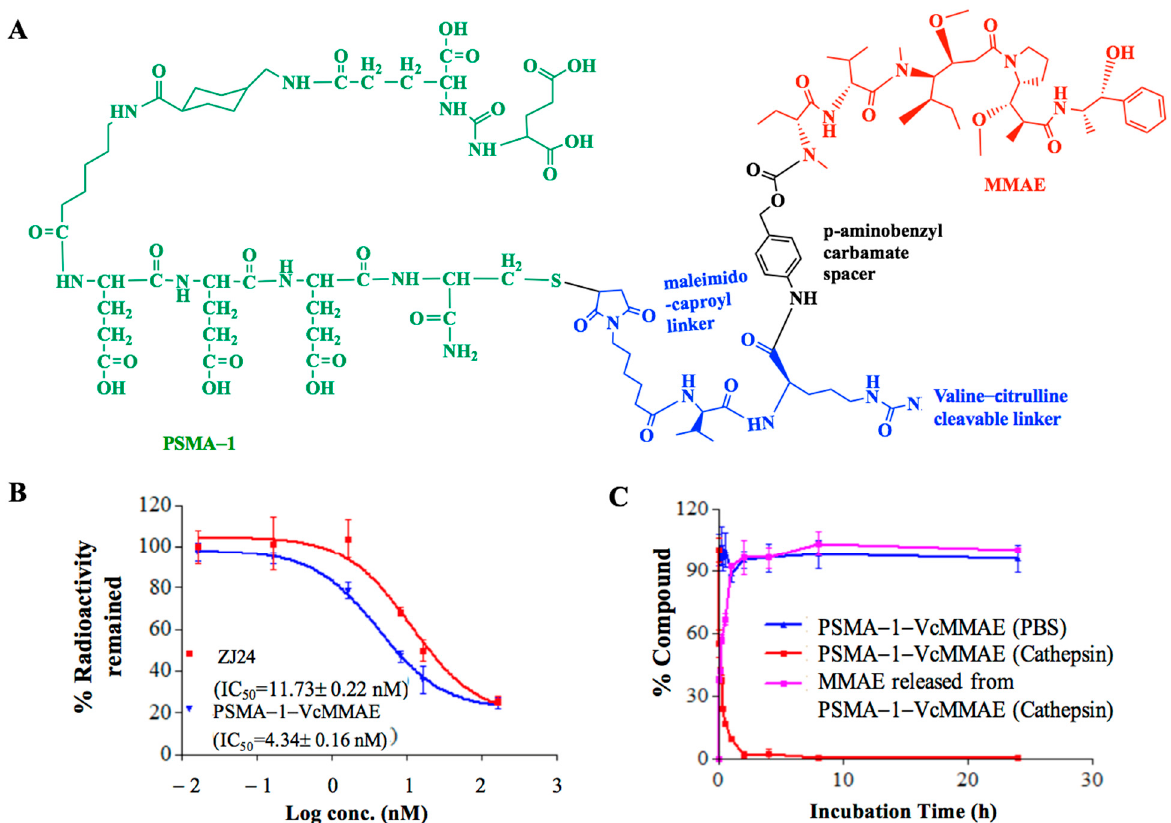
Figure 6. In vitro characterization of PSMA-1-VcMMAE. ( A ) Structure of PSMA-1-VcMMAE. ( B ) In vitro competition binding results of PSMA-1-VcMMAE. Values are mean ± SD of triplicates. ( C ) In vitro cathepsin cleavage of PSMA-1- VcMMAE. Values are mean ± SD of triplicates.